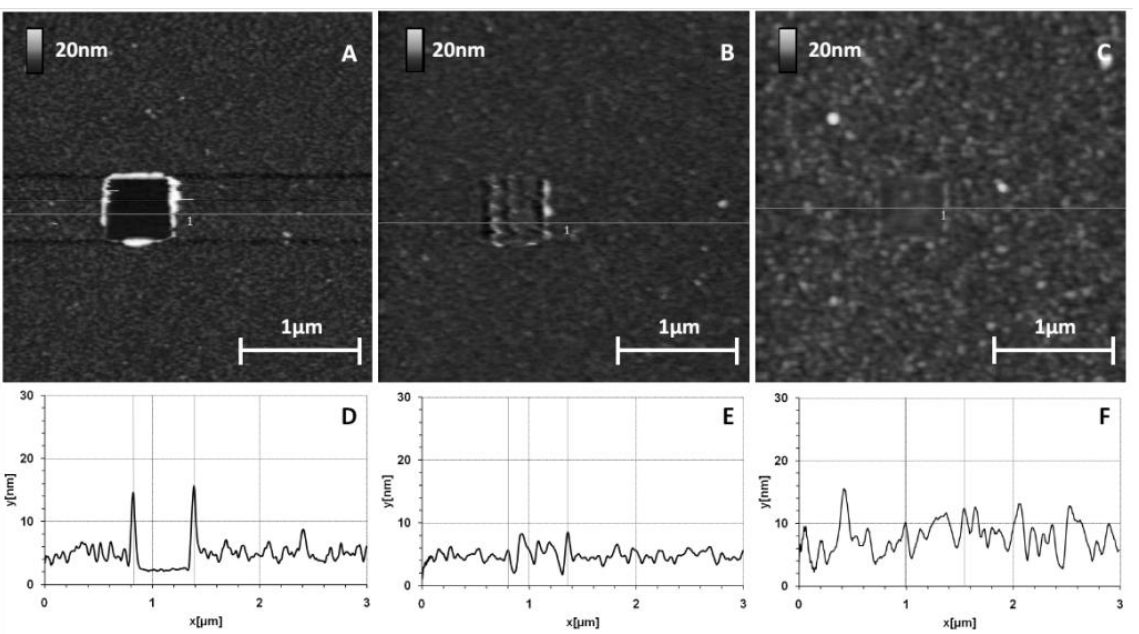
Figure 5. Atomic force microscopy (AFM) images of medium scrapings (stiff tip k = 0.12 N/m) applied on GaAs bio-functionalized surfaces and corresponding